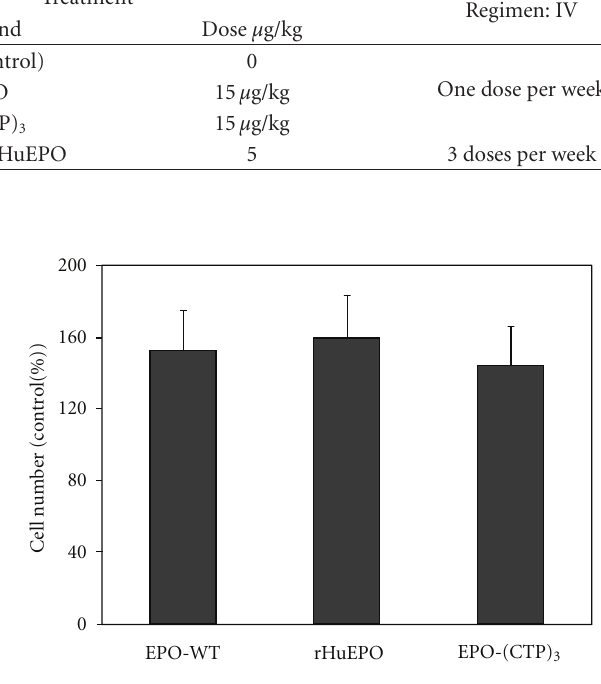
Figure 4: In vitro biological activity of recombinant hEPO deriva- tives. Bioactivity of EPO variants was tested by measuring the proliferation dependence of human erythroleukemicTF-1 cells in the absence or presence of 3IU of EPO variants. Cell proliferation was measured using MTT reagent